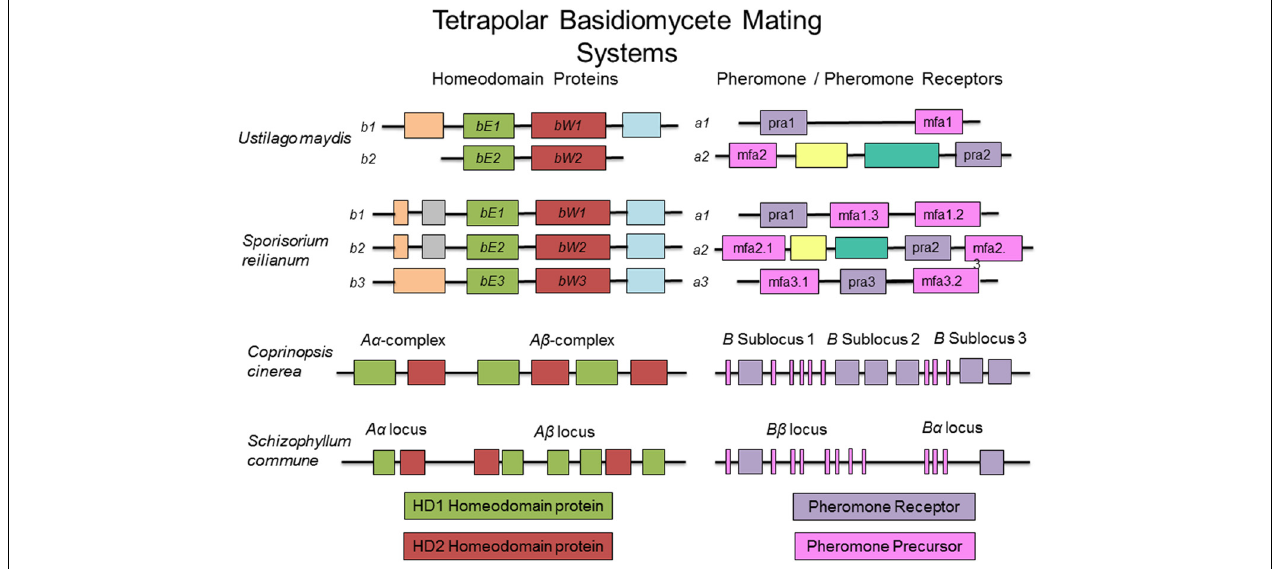
FIGURE 3 | Sample tetrapolar mating systems in basidiomycete fungi. While the number of homeodomain proteins may vary across this group, the composition of genetic material at the mating type loci is conserved. Boxes of the same color represent orthologous components in the different mating types and across species.